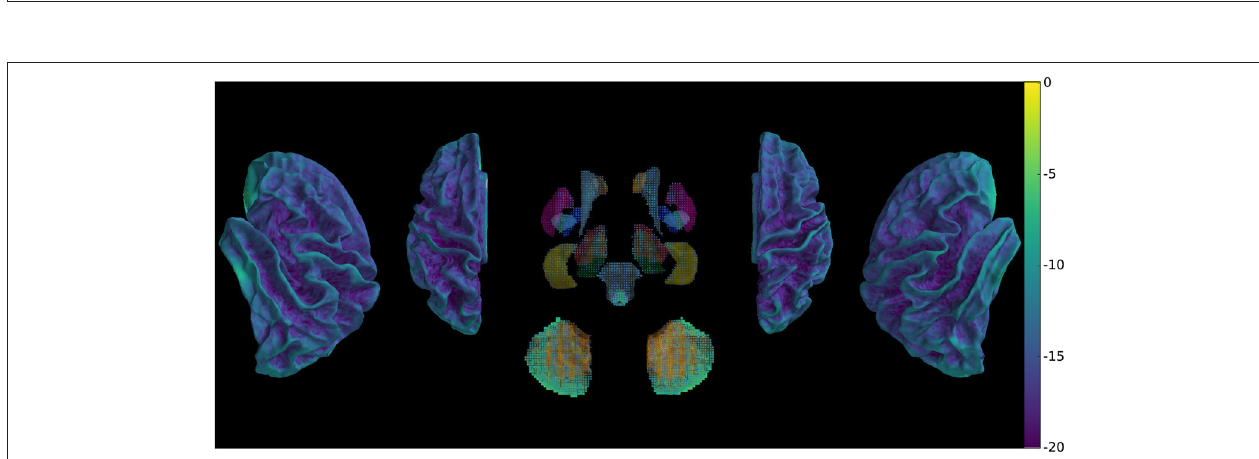
FIGURE 3 | Root mean square error statistics of motion and bias estimates per slice across simulations, for the single-slice acquisition simulations, using the proposed algorithm (blue) and MCFLIRT (red). The top and bottom slices show higher errors in motion slicewise estimates and for conventional volume registration, as well as in bias estimation.